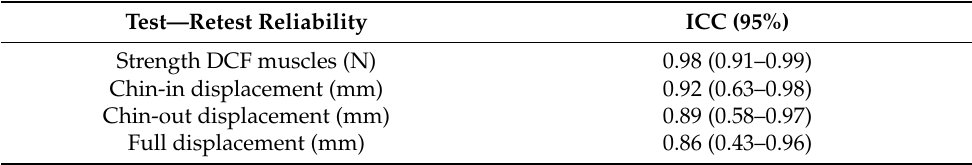
Table 2. Reliability of displacement movement and strength of deep cervical flexor